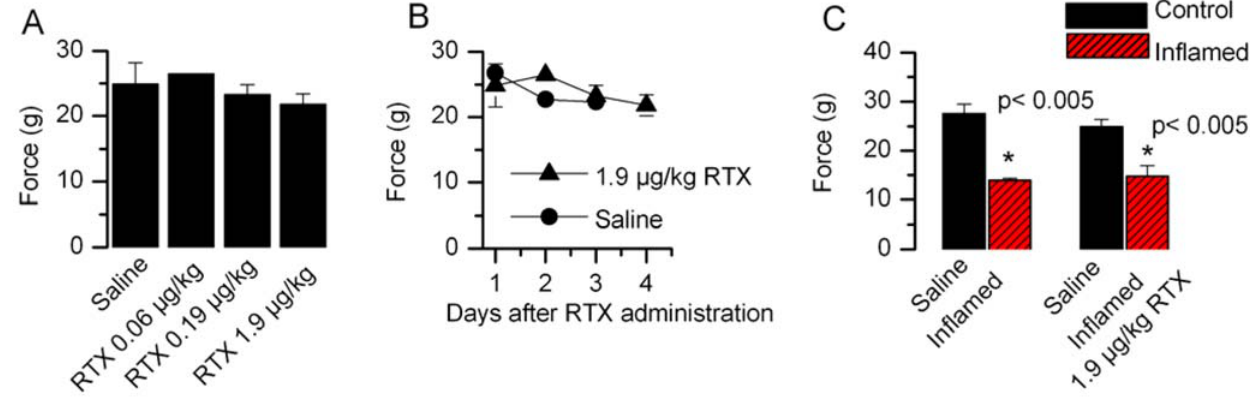
Figure 5. Intrathecal administration of RTX has no effect on mechanical sensitivity. A . There was no change in PWT with different concentrations of RTX. B. There was no change in PWT with time after intrathecal injection of RTX. C. Even after inflammation there was no change in PWT in response to mechanical stimulation.